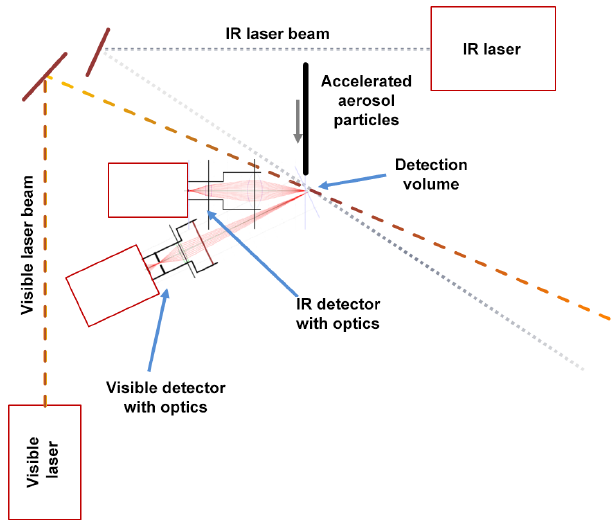
Figure 3. Drawing of the dual-wavelength optical measurement set-